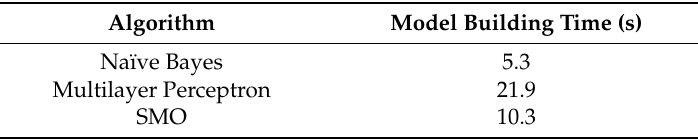
Figure 12. Workload analysis algorithms: Naïve Bayes, multilayer perceptron, and SMO comparisons based on correctly classified instances, incorrectly classified instances, Kappa statistic, mean absolute error, root mean squared error, relative absolute error, and root relative squared error. Table 1. Algorithms model building time.